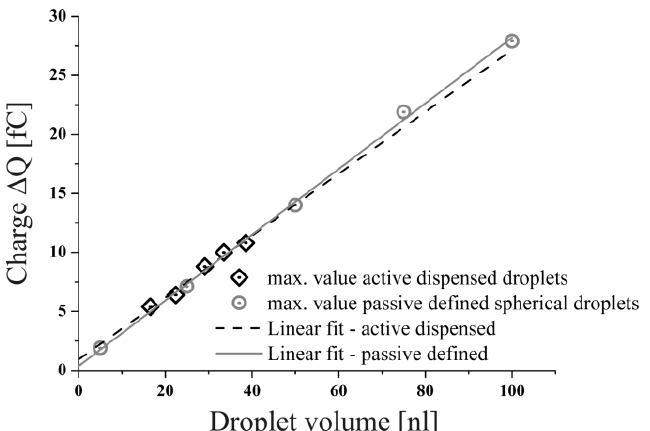
Figure 10. Correlation of droplet volume to the corresponding maximum change in charge for the spherical droplets as well as for the dispensed